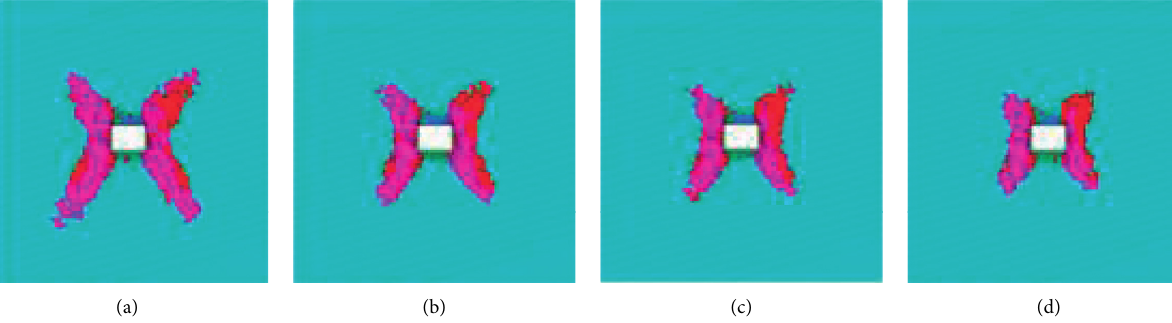
Figure 11: Morphology of plastic zone under different angle of internal friction of rock strata. (a) 43 ° . (b) 44 ° . (c) 46 ° . (d) 47 ° .